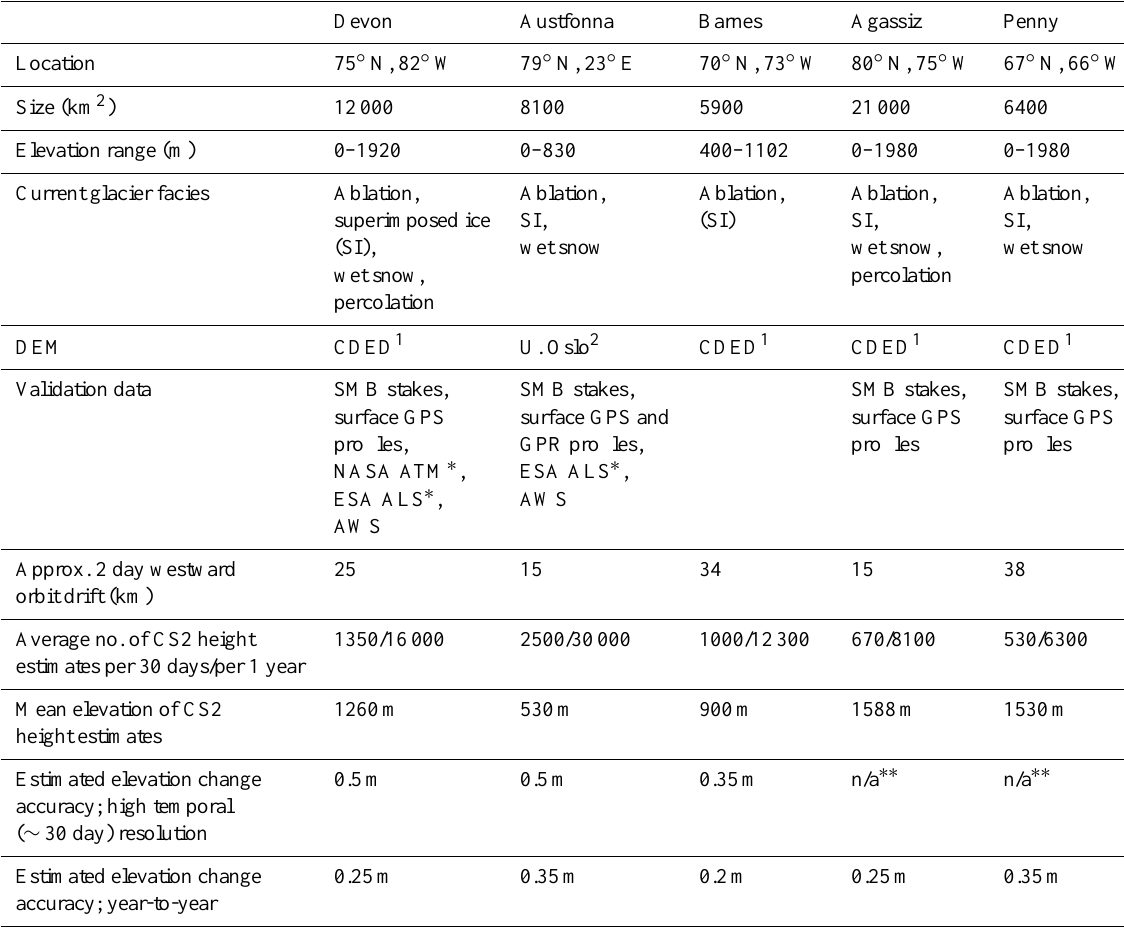
Table 1. Ice Cap